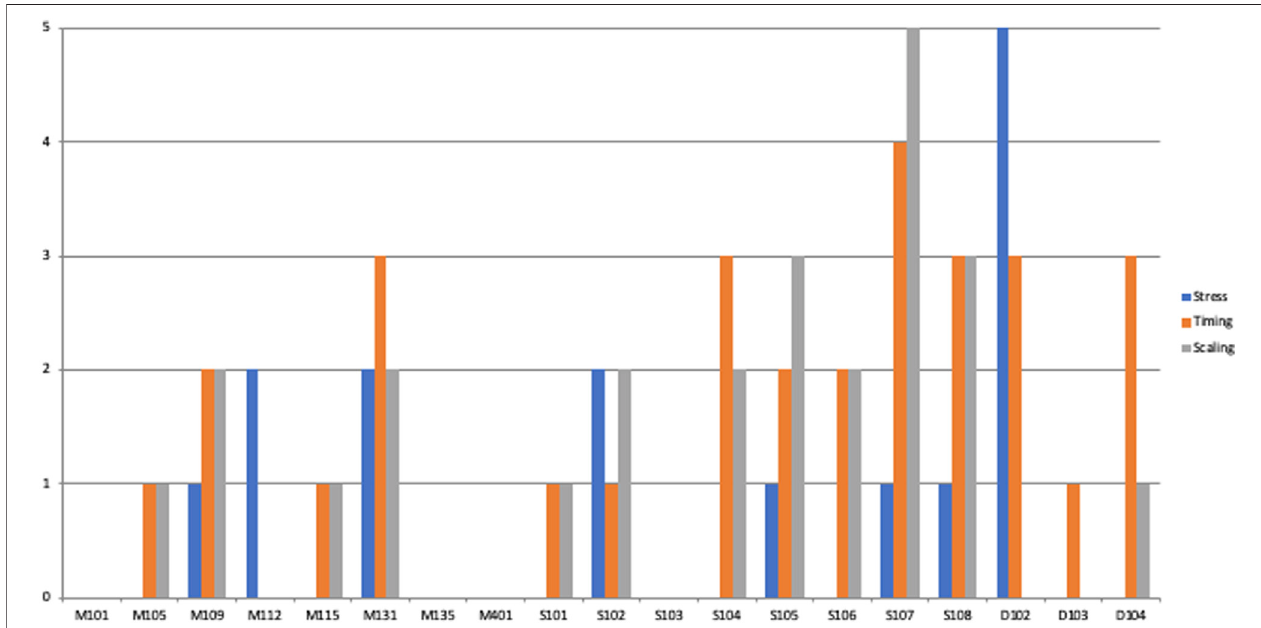
FIGURE 4 | Errors made by the individual participants in the Mark Zuckerberg-condition.